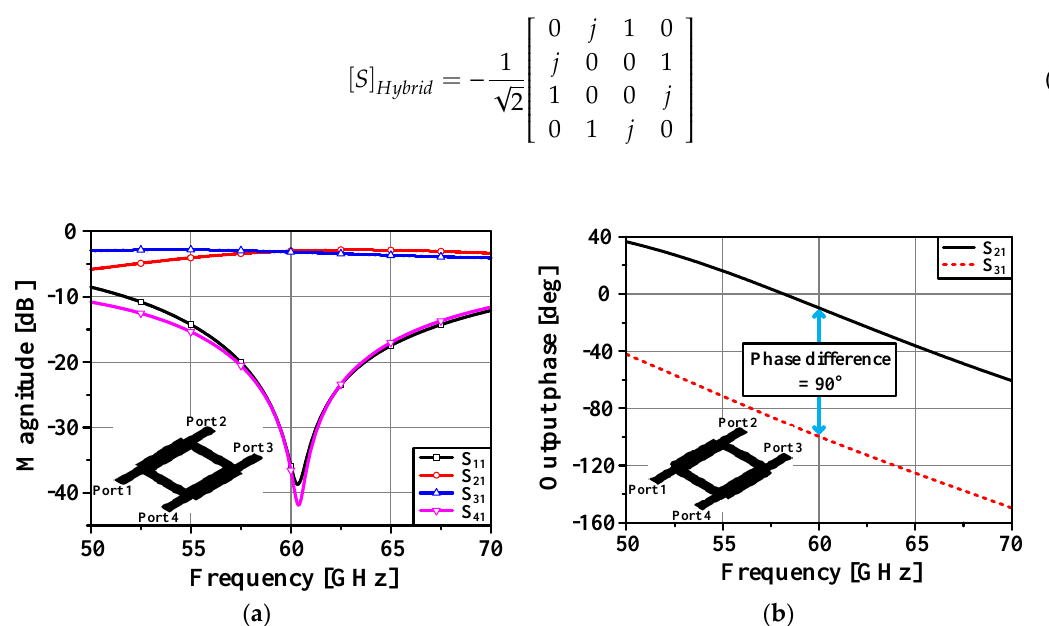
Figure 4. Simulated S-parameters of the quadrature hybrid coupler: ( a ) amplitude and ( b ) output phase.